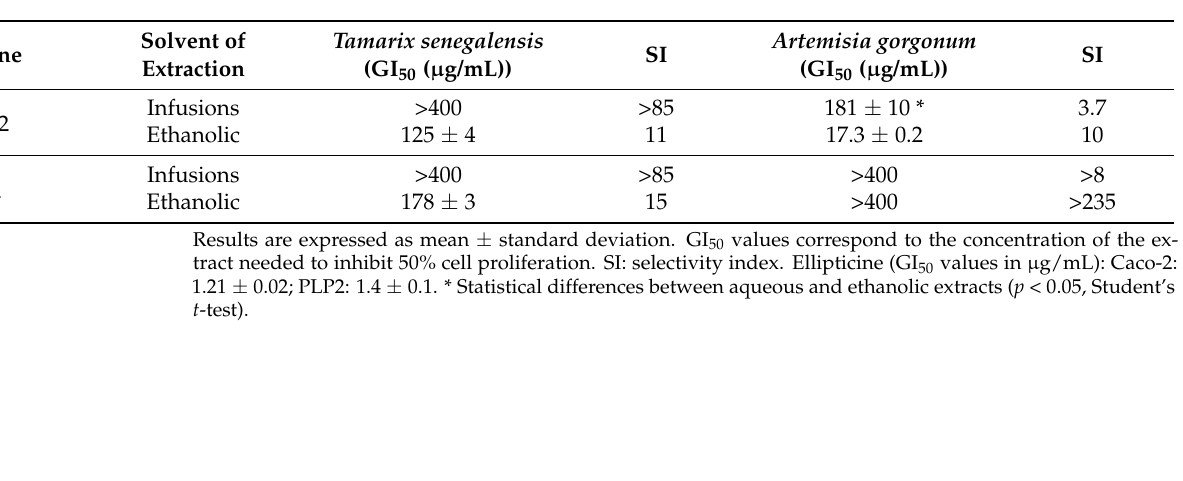
Figure 1. Treatment with infusions of T. senegalensis prevents trophozoite development. As can be seen, the parasite develops in the same way as the untreated control up to the 30 h time point. Treatment with A. gorgonum acts against early rings. In all time points, pyknotic nuclei were observed. Smears of synchronized 3D7 parasites treated with 5 ‐ fold EC 50 concentration were stained with Giemsa. Untreated control is represented in the first row, where parasites developed according to the expected timeline.